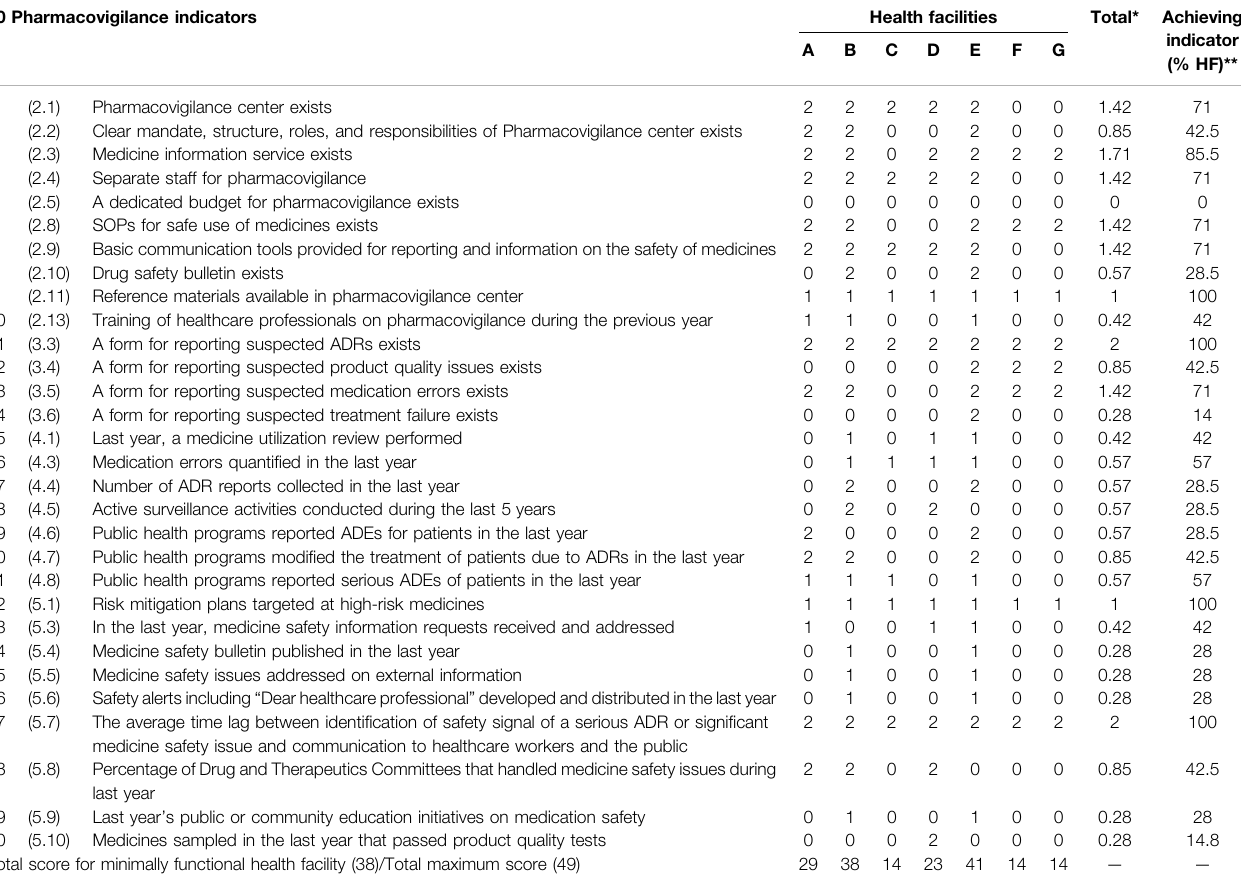
TABLE 4 | Health facilities pharmacovigilance